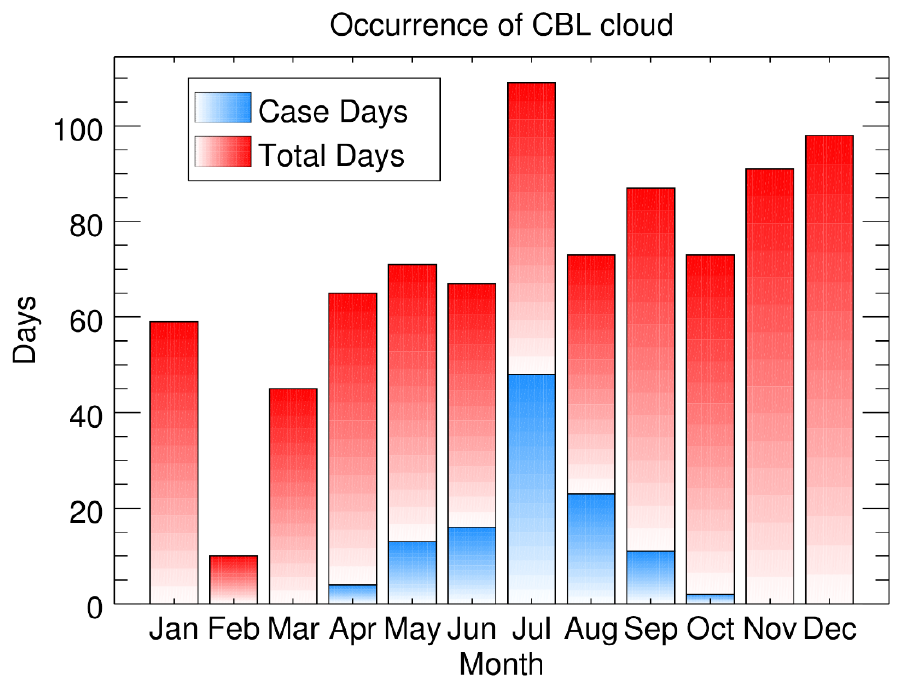
Figure 6. Monthly occurrence statistics of the shallow cumulus days based on the 848 day lidar observations from 2011 to 2019 at Wuhan, China (30.5°N, 114.4°E). The red bar represents the number of lidar observational days in each month, while the blue bar denotes the number of cumulus cloud days. A total of 117 cumulus cloud days were identified from the 848 day lidar observations. Each cumulus cloud day contained at least 10 cumulus cloud events.